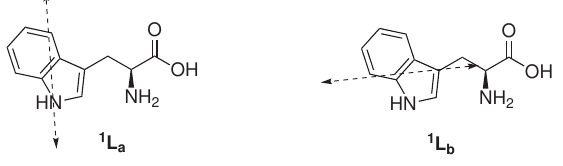
Figure 1. Electronic absorption transitions in tryptophan